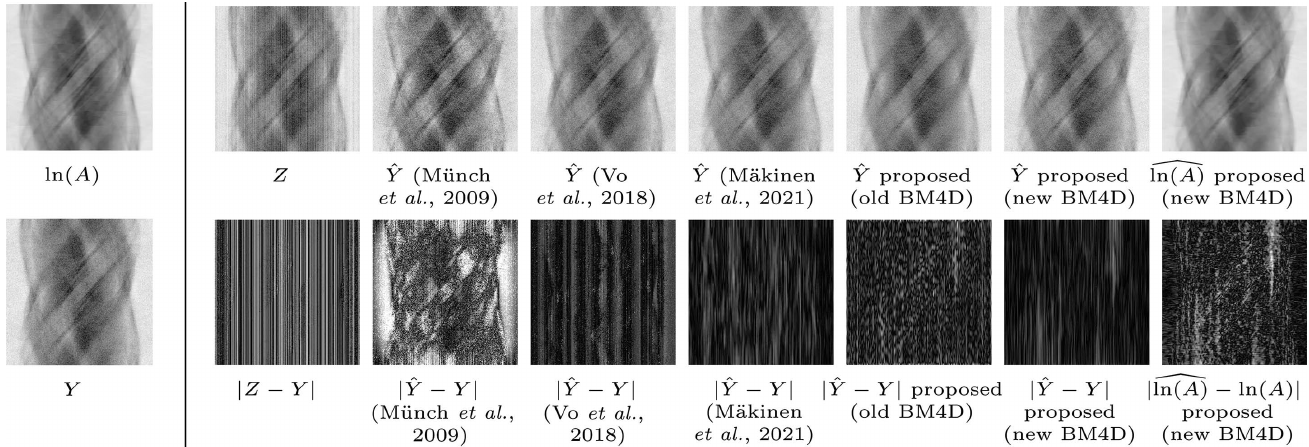
Figure 4 g = 0.02 and signal peak 2560, displaying a single sinogram extracted from the Denoising of the 3-D BrainWeb phantom with noise as in (3) with std f (cid:2) P stack. Left: a sinogram of ln( A ) (3) and the corresponding streak-free but noisy sinogram of Y (5). Right: on top, noisy sinogram Z (4) and the comparison of estimates: ^ YY for Mu ¨ nch et al. (2009), Vo et al. (2018), Ma ¨ kinen et al. (2021), the proposed framework using old BM4D and using improved BM4D, and d ln ð A Þ ln ð A Þ with the proposed framework and new BM4D. Below, corresponding estimation errors. Note that the errors j ^ YY (cid:2) Y j show only the effectiveness of streak removal, as the compared algorithms are designed for streak attenuation, whereas j d ln ð A Þ ln ð A Þ (cid:2) ln ð A Þj shows the complete denoising error, scaled separately. Notably, the proposed algorithm offers superior performance, but only when embedded with the improved